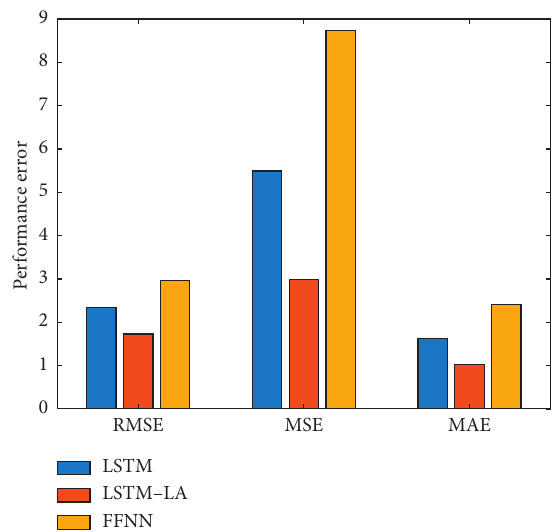
Figure 5: Comparative plot of monthly forecast GWL using FFNN, LSTM, and LSTM-LA.